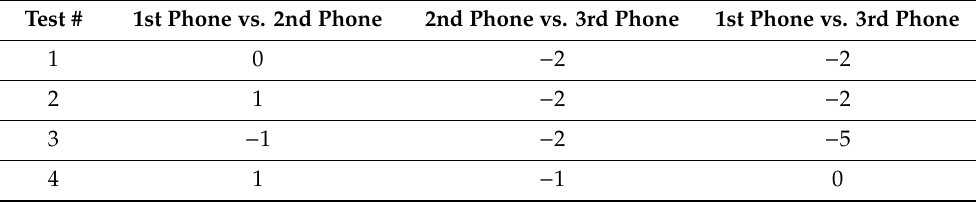
Table 3. Time synchronization errors between any two sensor smartphones (millisecond).